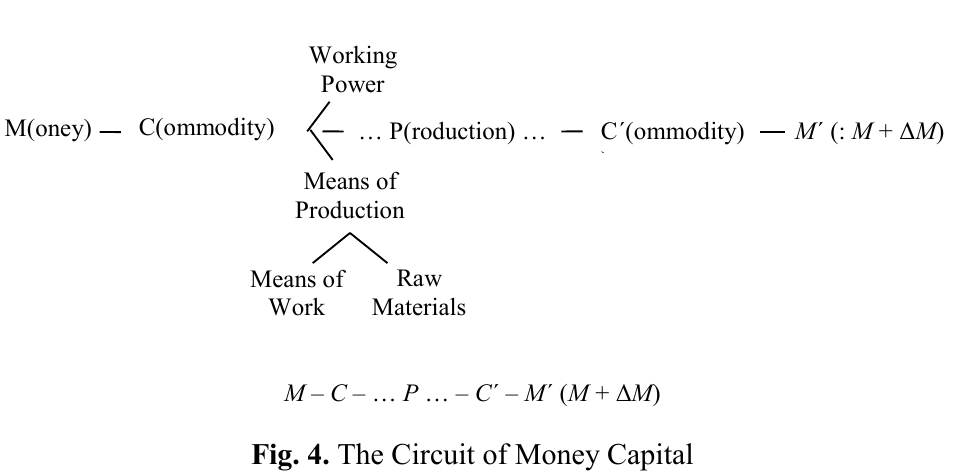
Fig. 4. The Circuit of Money